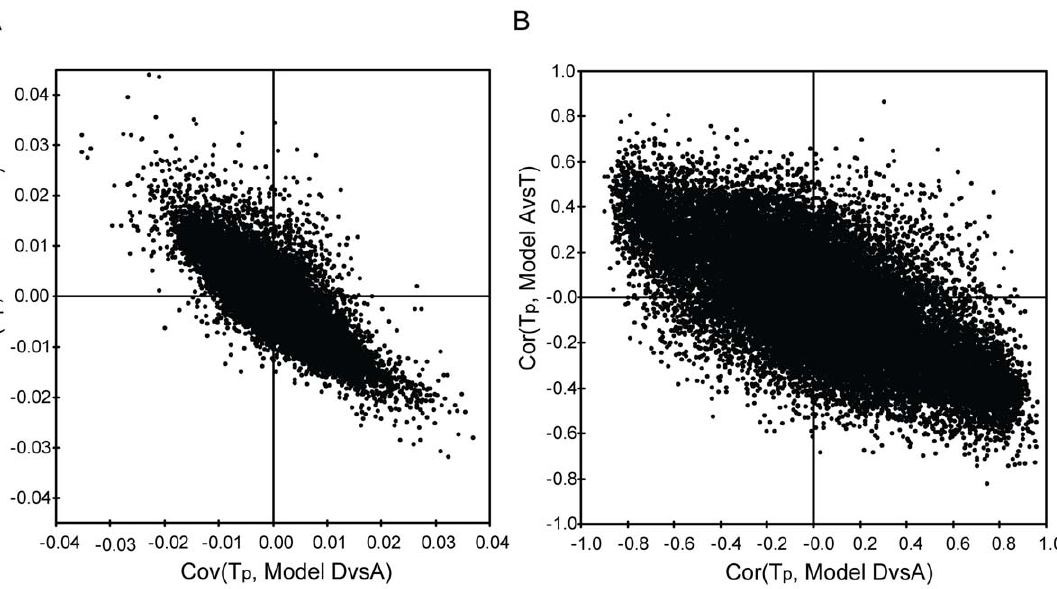
Figure 3. Comparison between Model DvsA and Model AvsT derived from the training set. A ) Comparison of the Cov(Tp) of all genes between Model DvsA and Model AvsT; B ) Comparison of the Cor(Tp) of all genes between Model DvsA and Model AvsT. D, diluent-challenged CD4 + T cells; A, allergen-challenged CD4 + T cells; T, allergen-challenged + GC treated CD4 + T cells. Cov(Tp), the covariance of the predictive component; Cor(Tp), the correlation of the predictive component.